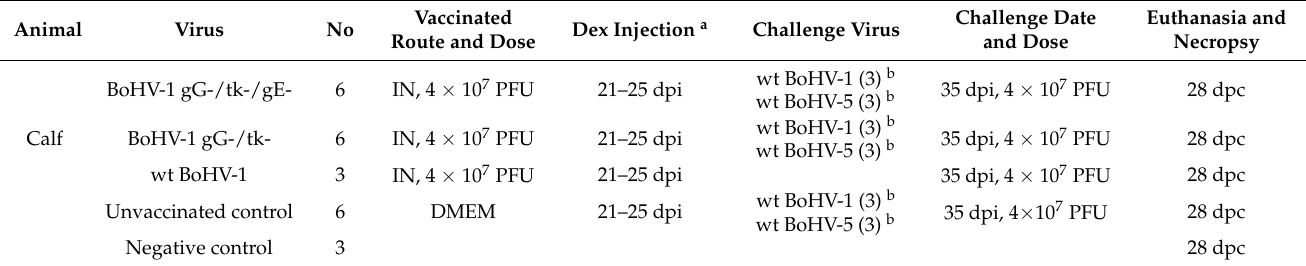
Table 1. Experimental